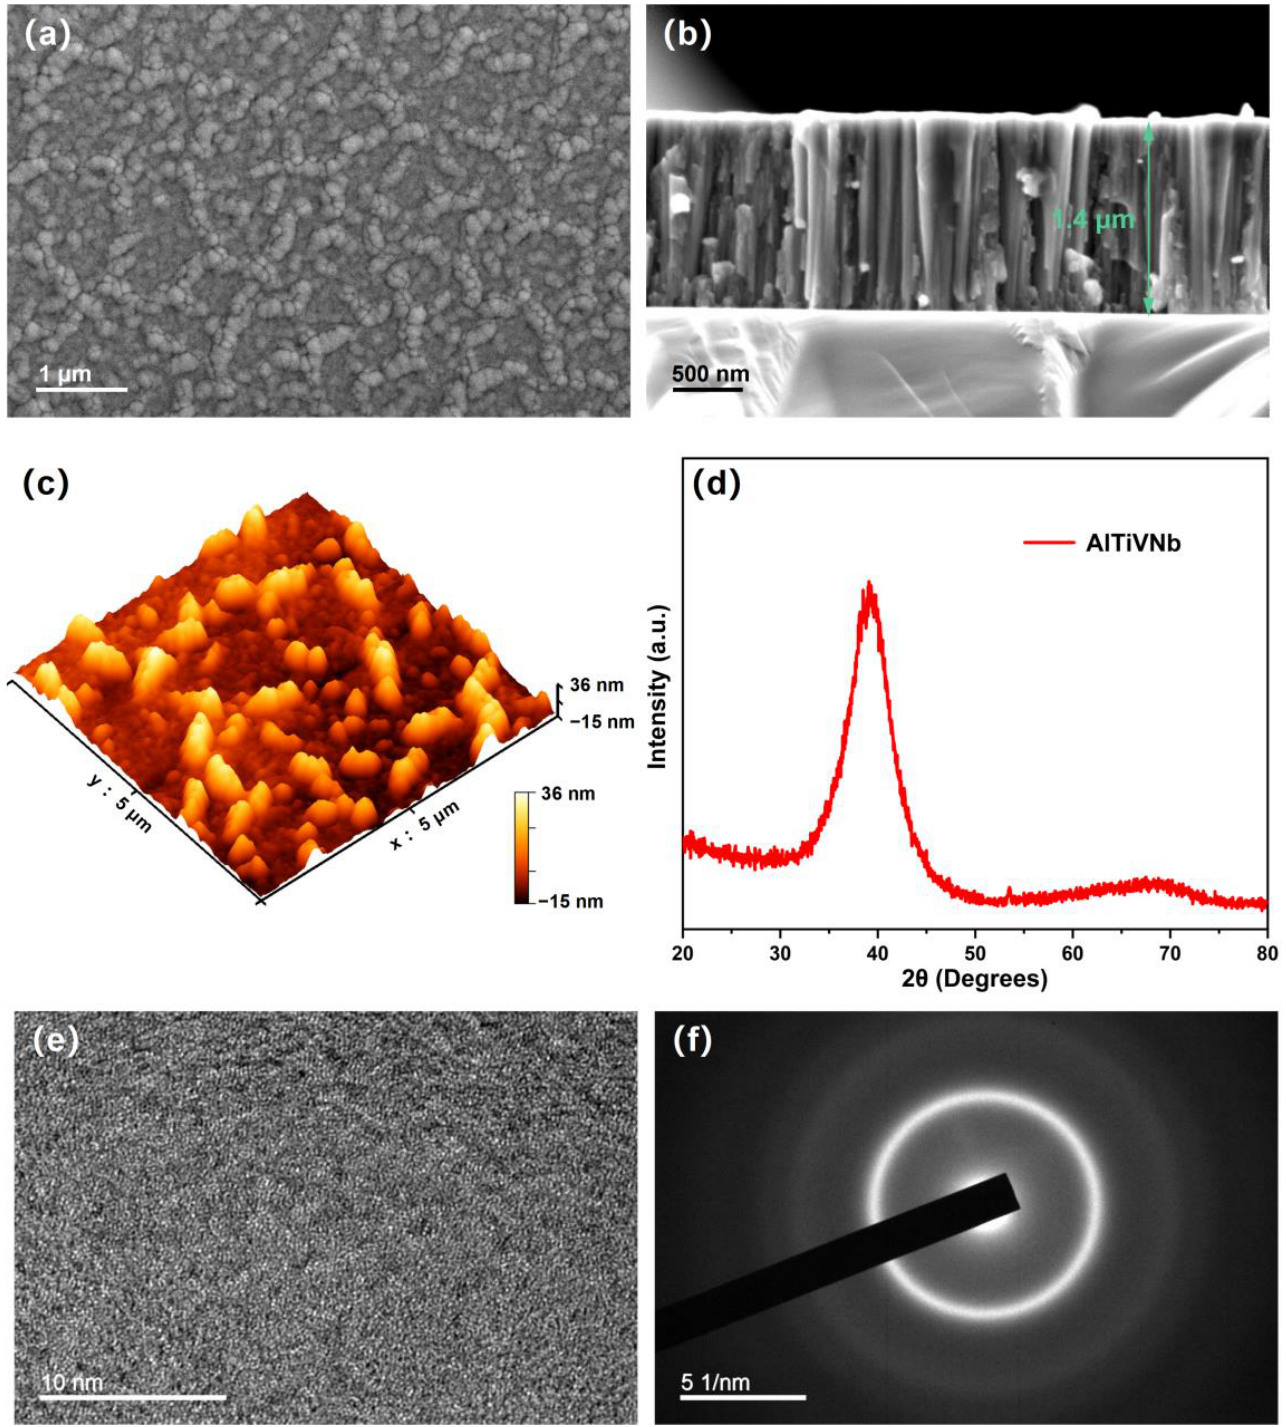
Figure 1. The morphology and phase structure of the AlTiVNb HEA film. ( a ) The SEM surface morphology of the film; ( b ) Cross-section morphology; ( c ) 3D surface topography by AFM; ( d ) XRD pattern, showing an amorphous structure; ( e ) The bright field HRTEM image of the film; ( f ) The corresponding SAED patterns.